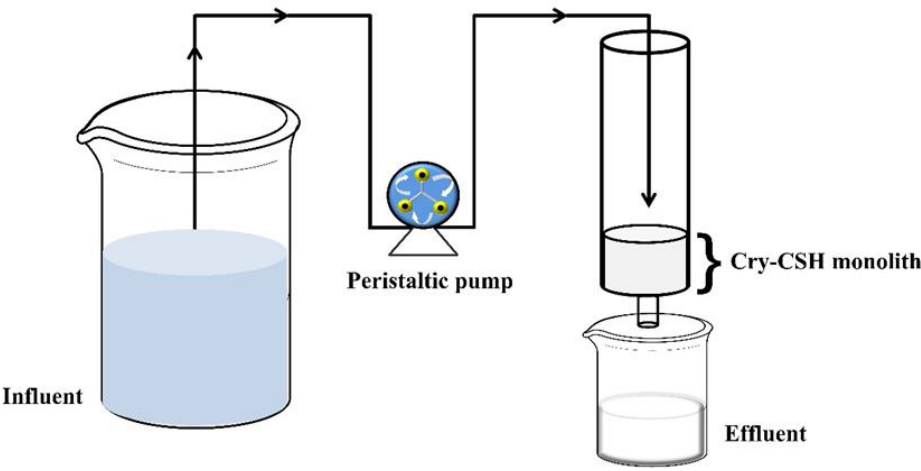
Figure 1. Schematic flowchart of an experiment design for column absorption study.